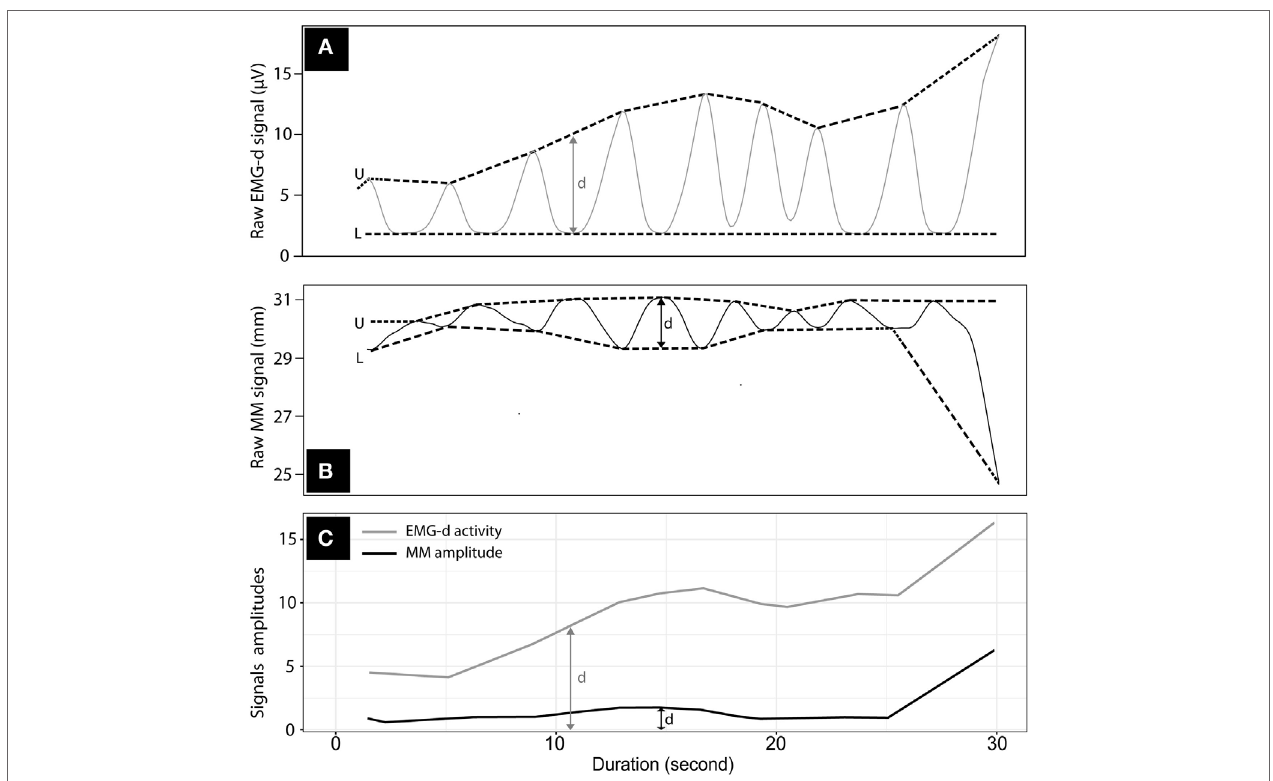
FigUre 2 | Computerized envelop processing around the traces of Mandibular movements (MM) and diaphragmatic electromyography (EMG-d) over 30 s. Envelop processing on raw signals of EMG-d (a) and MM (b) ; U = Upper-band; L = Lower band; d = amplitude, determined as the difference between upper and lower bands; (c) traces of enveloped EMG-d (gray line) and MM (black)